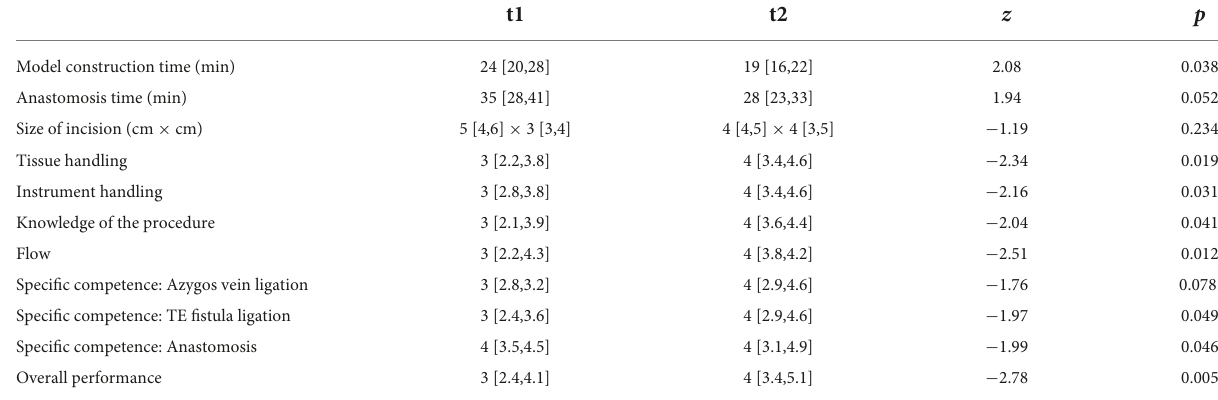
TABLE 2 Observer